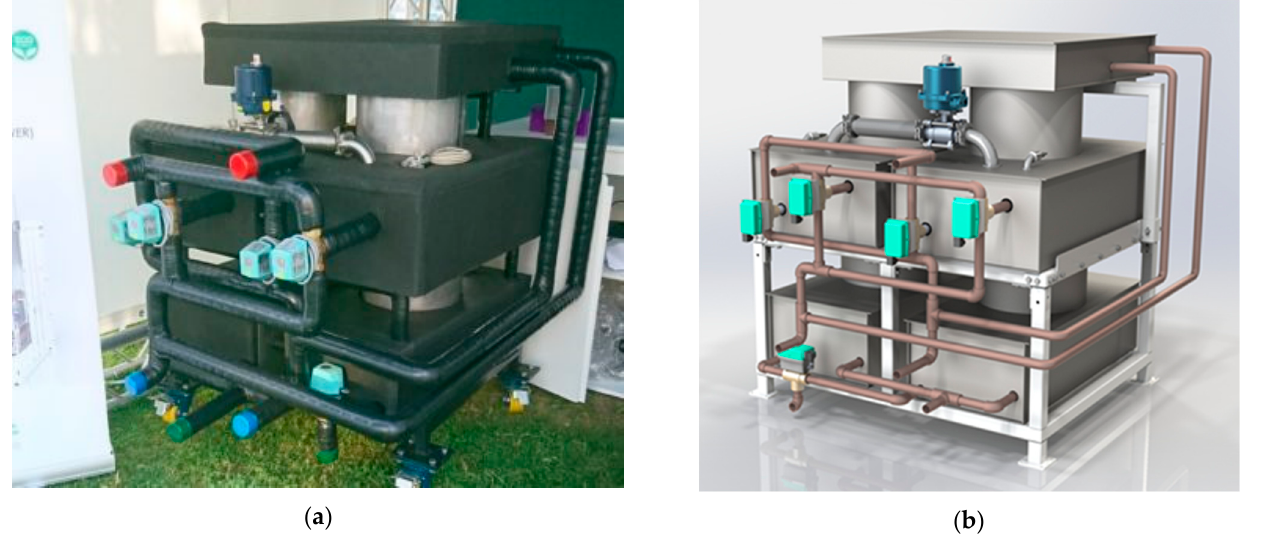
Figure 7. PI prototype adsorption chiller: ( a ) prototype, ( b ) 3D model.